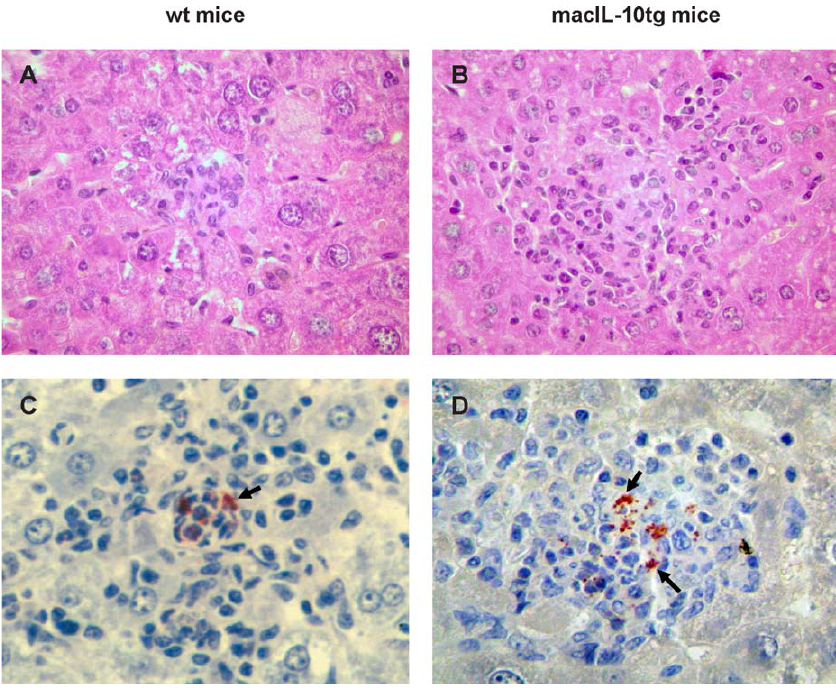
Figure 2. Liver Granulomas in WT and macIL-10tg Mice (A and B) Granulomas in the liver parenchyma of wt (A) and macIL-10tg (B) mice were revealed by hematoxylin-eosin staining. Representative micrographs of granulomas present at day 7 post-infection were shown ( 3 400 original magnification). Note that granulomas were mainly composed of macrophages and were greater in macIL-10tg mice than in wt mice. (C and D) Liver sections from wt (C) and macIL-10tg (D) mice were deparaffinized and rehydrated, and C. burnetii organisms were revealed by immunohistostaining. Macrophages in inflammatory granulomas present in liver lobules were packed with granular immunopositive material (indicated using arrowheads). Immunopositive material was more abundant in macIL-10tg than in wt